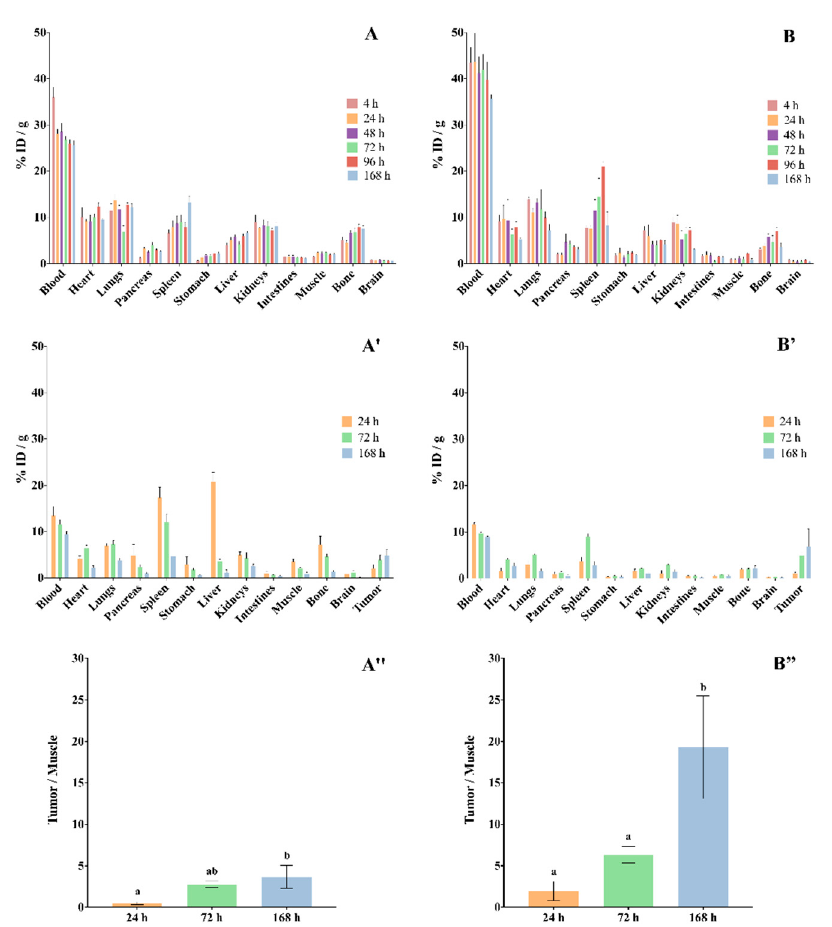
Figure 7. Biodistribution of ( A ) [ 111 In]In-DTPA-trastuzumab and ( B ) [ 177 Lu]Lu-DOTA-trastuzumab in mice. ( A ) and ( B ) normal female BALB/c mice. ( A ′ ) and ( B ′ ) SK-BR-3 breast-tumor-bearing female BALC/c nude mice. ( A ″ ) and ( B ″ ) Target-to-non-target ratio (tumor/muscle). Values are expressed as mean ± SEM ( n = 4–5). Different letters indicate significant differences ( p < 0.05). ID—injected dose.